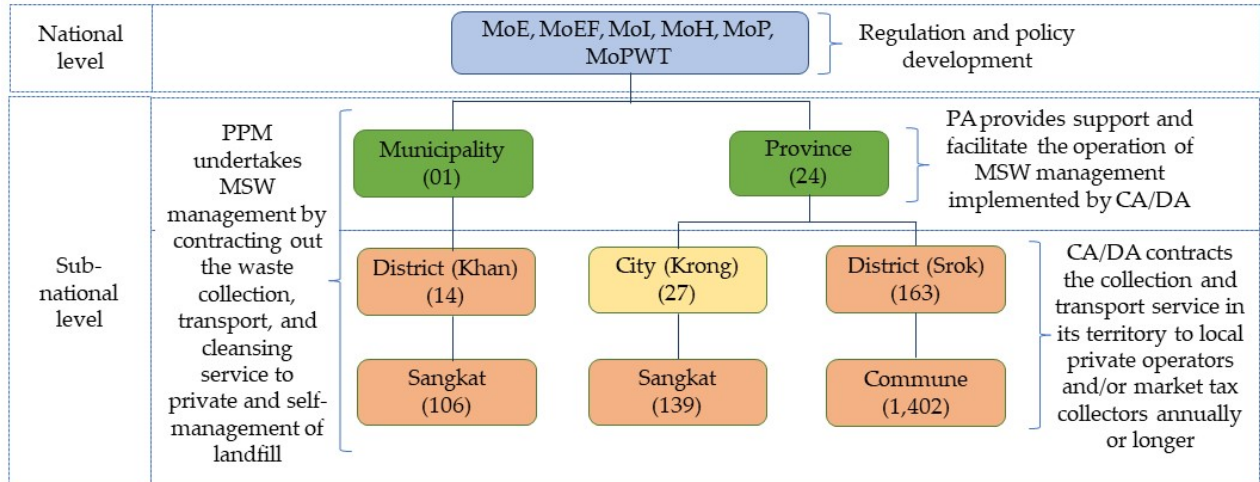
Figure 2. MSW management arrangement in Cambodia.